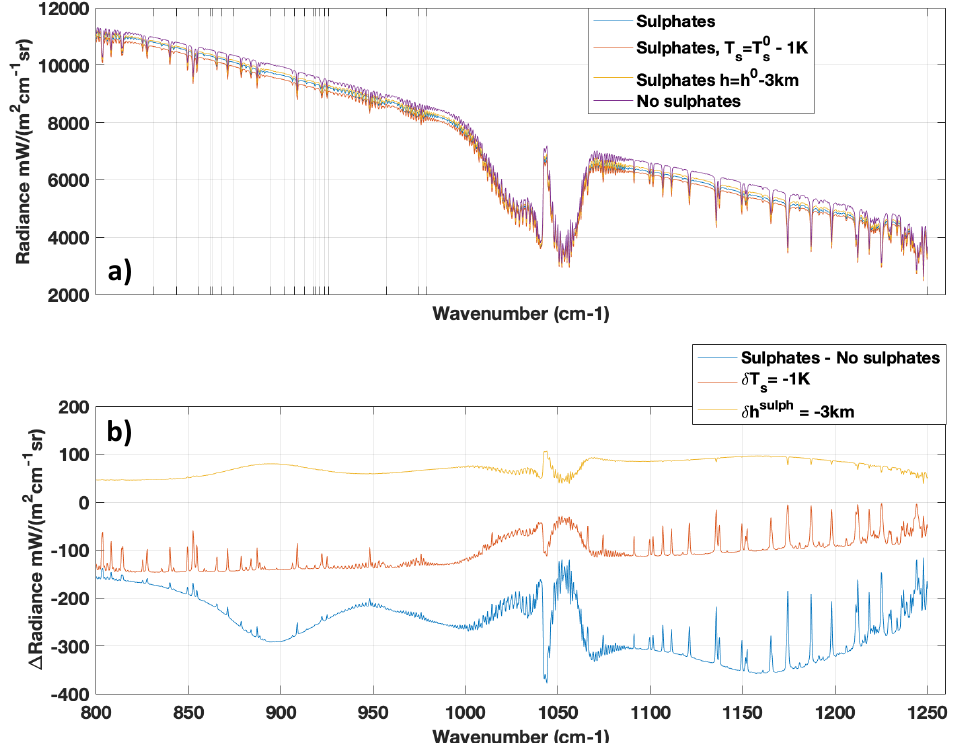
Figure 2. ( a ) The AEROIASI-H2SO4 fitted spectrum of Figure 1 (in blue) along with spectra at the same conditions but 1 K colder temperature (orange), same temperature but SA plume at 3 km lower altitude (yellow) and without SA plume (purple); ( b ) Spectral radiance variation of the AEROIASI-H2SO4 fitted spectrum and the different conditions of ( a ). The spectral micro-windows of AEROIASI-H2SO4 are indicated as vertical lines in ( a